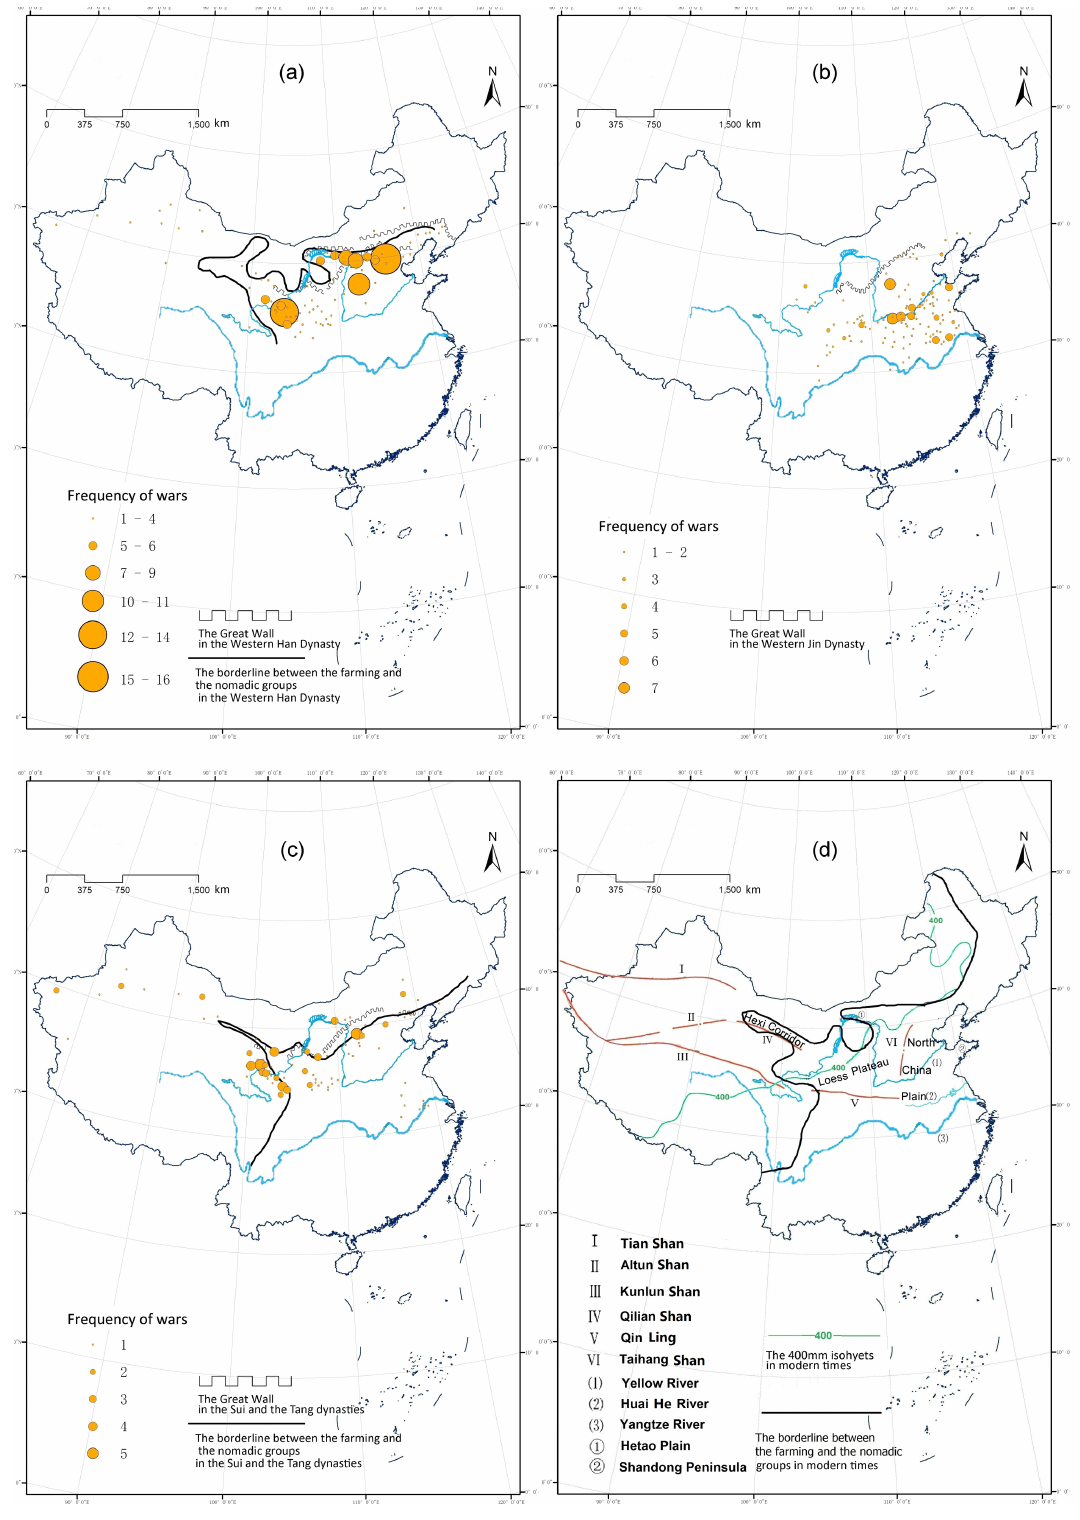
Figure 3. Distribution of ethnic wars in different periods (panel a : 210BC–AD220; panel (b) : AD221–580; panel (c) : AD581–906) and basic geomorphology units (d) in